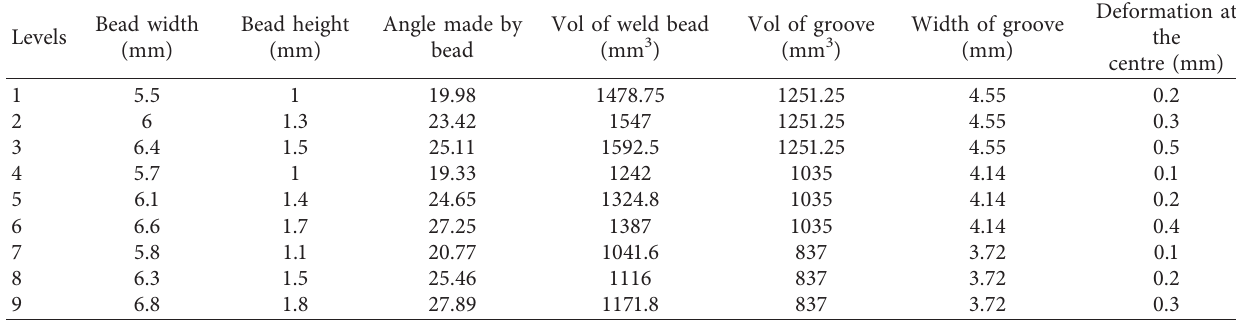
Table 7: Structural results of single V 45 °